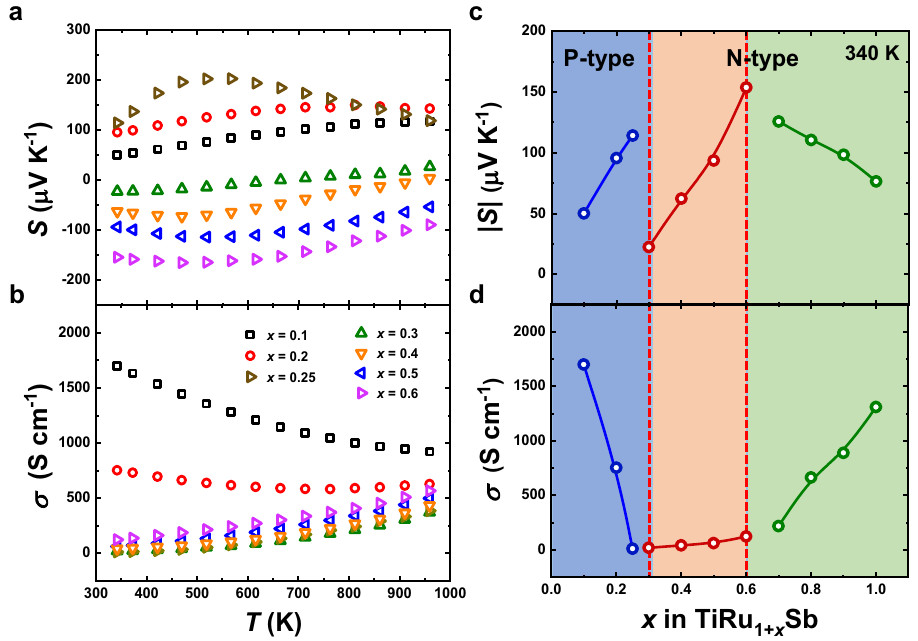
Fig. 4 Electrical transport properties of TiRu 1 + x Sb samples. a , b Temperature-dependent Seebeck coef fi cients ( a ) and electrical conductivities ( b ) above room temperature. c , d Ru content-dependent Seebeck coef fi cients ( c ) and electrical conductivities ( d ) at 340 K.